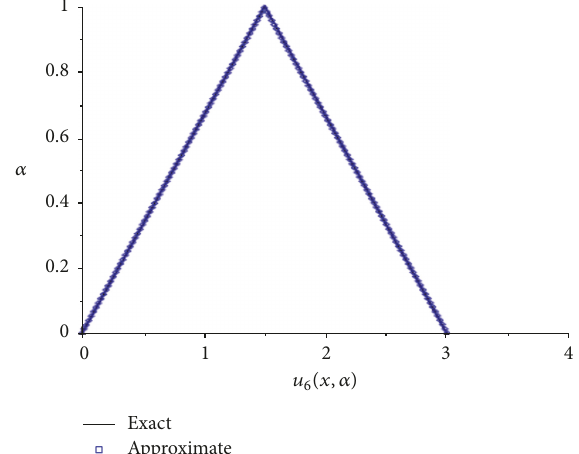
Figure 3: Exact and numerical solutions at 𝑥 = 𝜋/8 .